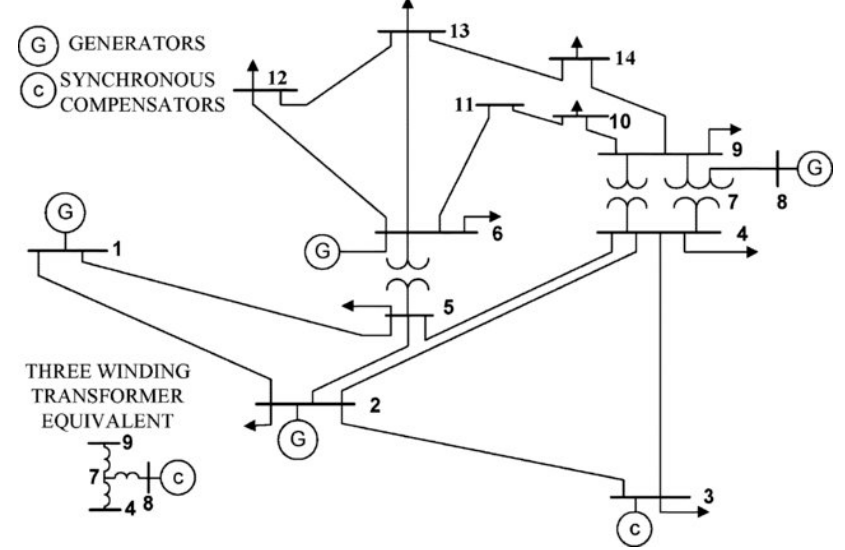
Figure 10. Single-line diagram of the IEEE 14-bus benchmark system [130].